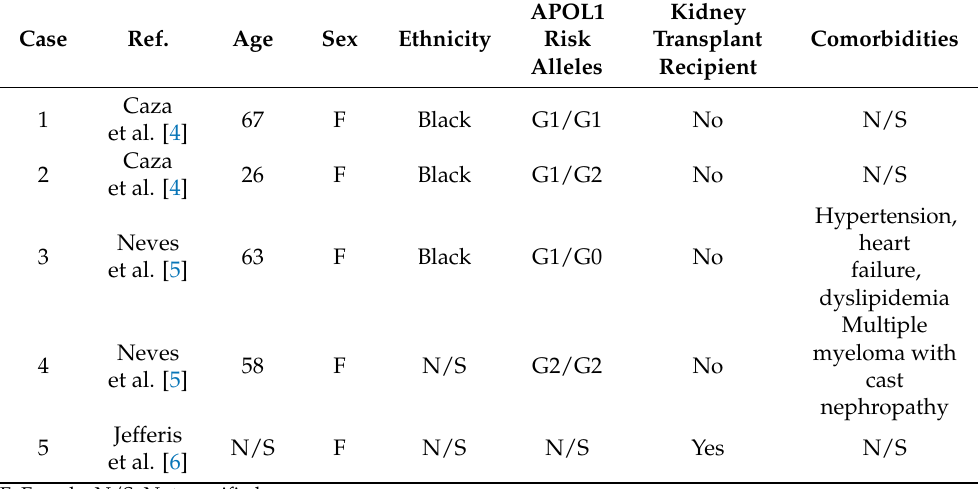
Table 1. Cases of CollapsingGlomerulonephritis followingSARS-CoV-2 vaccination. Baselinecharacteristics.